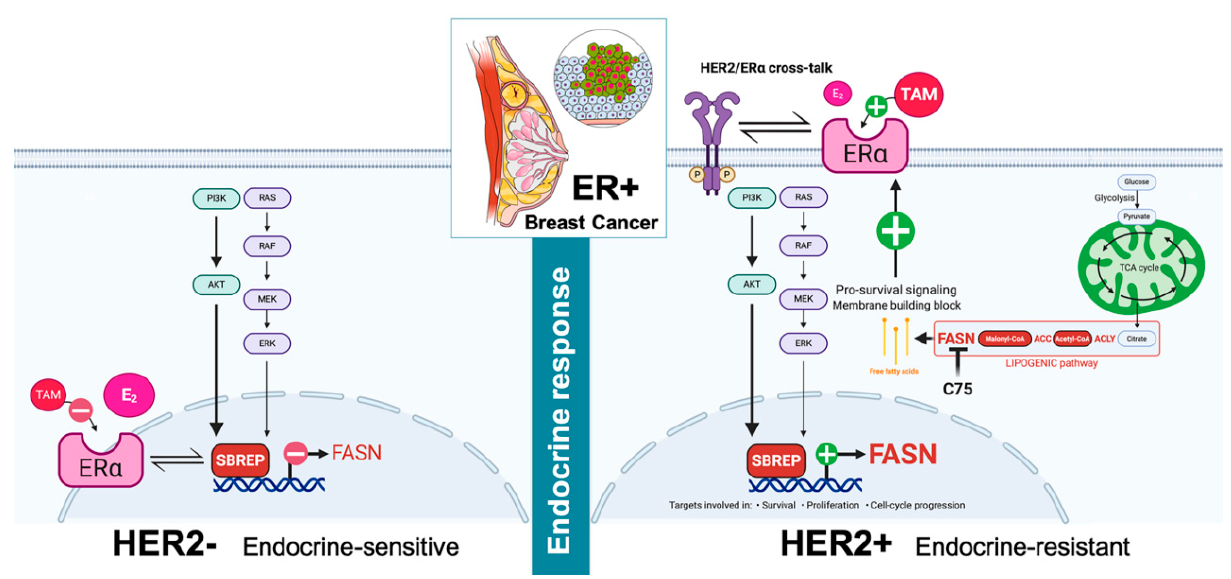
Figure 8. FASN enables HER2-driven breast cancer resistance to tamoxifen. The stimulatory effects of estradiol on FASN expression can be blunted by anti-estrogens in endocrine-responsive ER-positive/HER2- negative breast cancer cells (left). In ER positive/HER2- positive breast cancer cells, however, an AKT/MAPK-related constitutive hyperactivation of FASN expression becomes unaltered in response to estradiol and could be further enhanced by tamoxifen (right). FASN pro-survival signaling is co-opted by HER2 pathway activation to enable breast cancer resistance to tamoxifen. FASN inhibitors may be clinically relevant to countering resistance to tamoxifen in luminal B-like, ER+/HER2+ breast carcinomas. Created with BioRender.com and Mindthegraph.com.